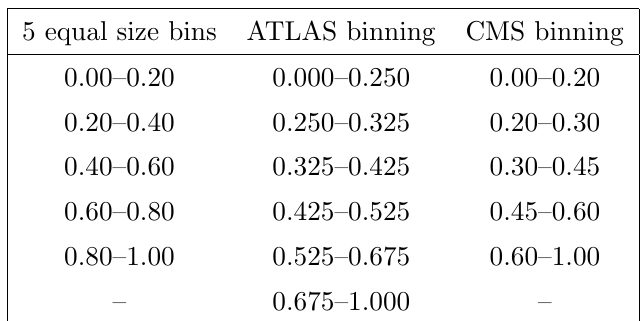
Table 3 . Various binnings used in the m t extraction from the normalised (cid:26) s distribution. The three cases are shown: 5 equal size intervals as well as ATLAS [26] and CMS [27] intervals. The latter two have been optimised for the ‘ +jets and di-lepton channels at p s = 7 TeV and p s = 8 TeV